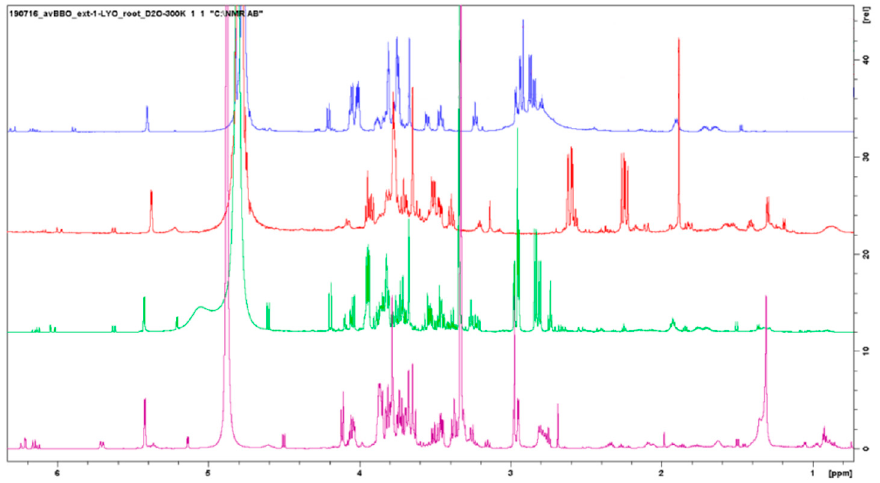
Figure 7. Comparison between 4 types of Posidonia oceanica roots extracts: acid extract (blue signal), alkaline extract (red signal), CH 3 OH 50% extract (green signal), and CH 3 OH 100% extract (purple signal).